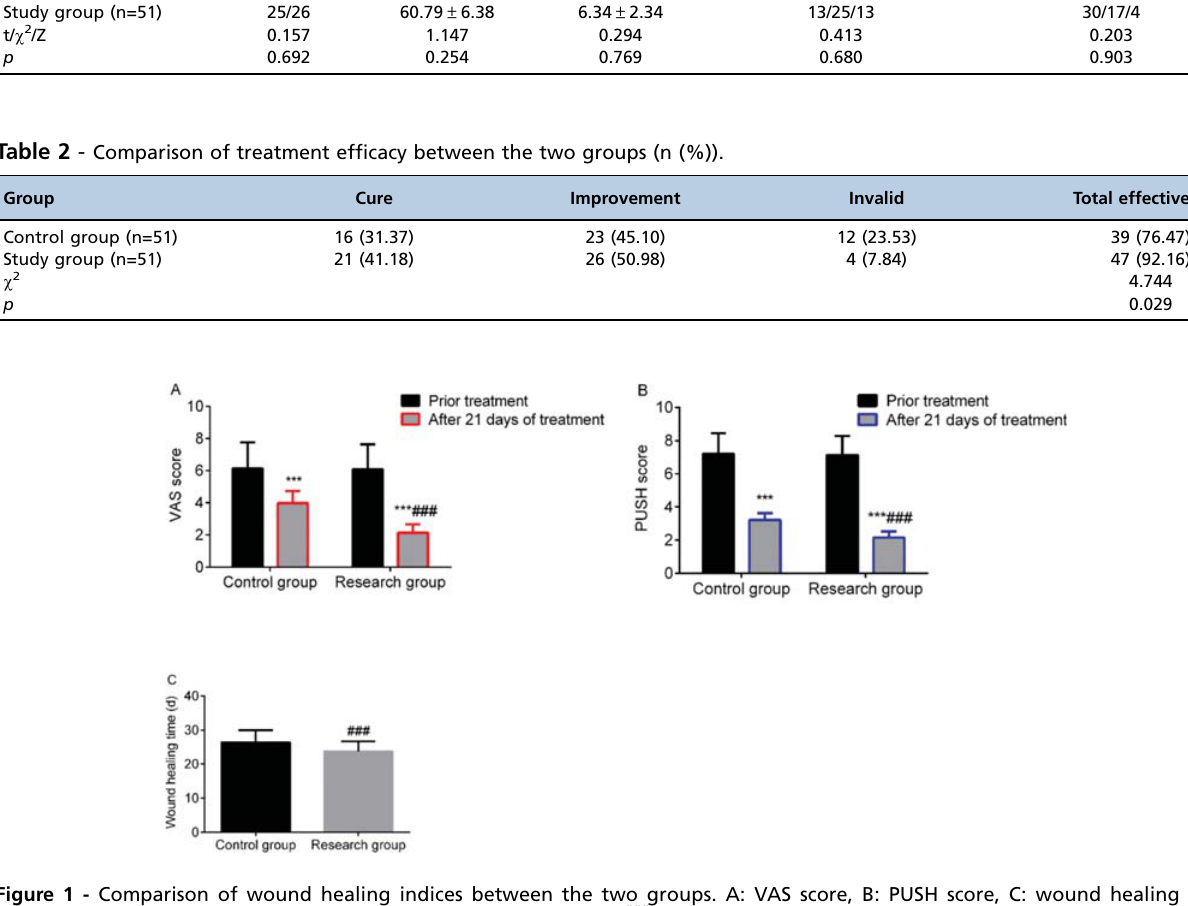
Figure 1 - Comparison of wound healing indices between the two groups. A: VAS score, B: PUSH score, C: wound healing time. *** indicates p o 0.001 when compared to levels before treatment; ### indicates p o 0.001 when compared to the control group. VAS: Visual analog scale; PUSH: Pressure Ulcer Scale for